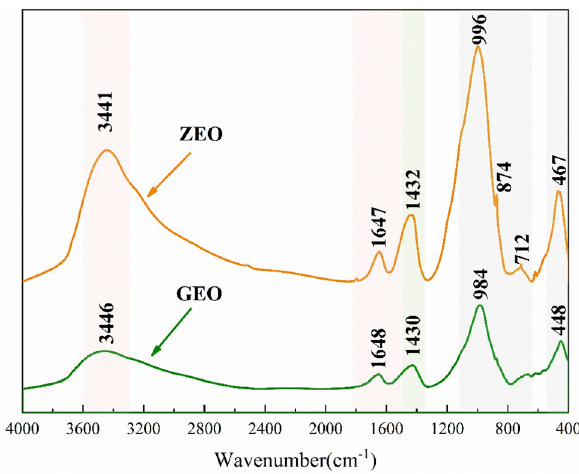
Figure 9. The infrared spectra of the geopolymer (GEO) and the final product (ZEO).